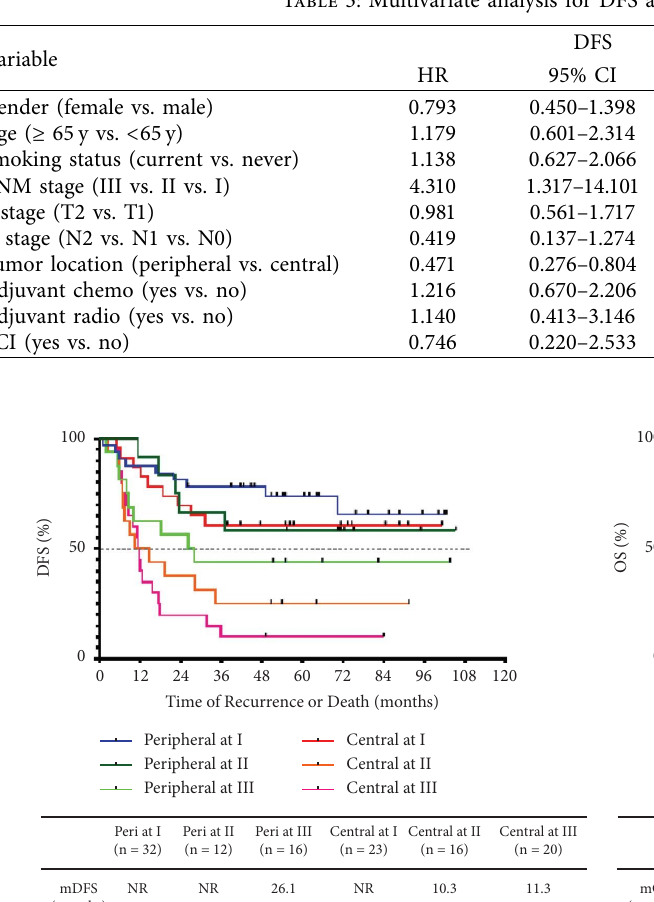
Table 3: Multivariate analysis for DFS and OS in resected LS SCLC.